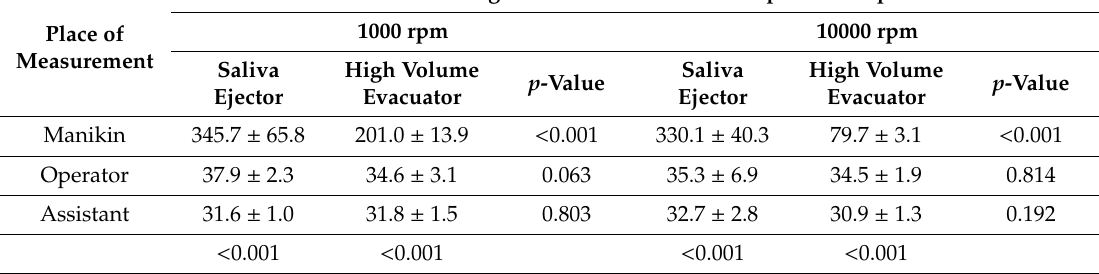
Table 2. The amount of the dental spray during tooth’s polishing measured in 3 areas and the analysis of variance and post-hoc test (multiple comparisons using the Tukey test).